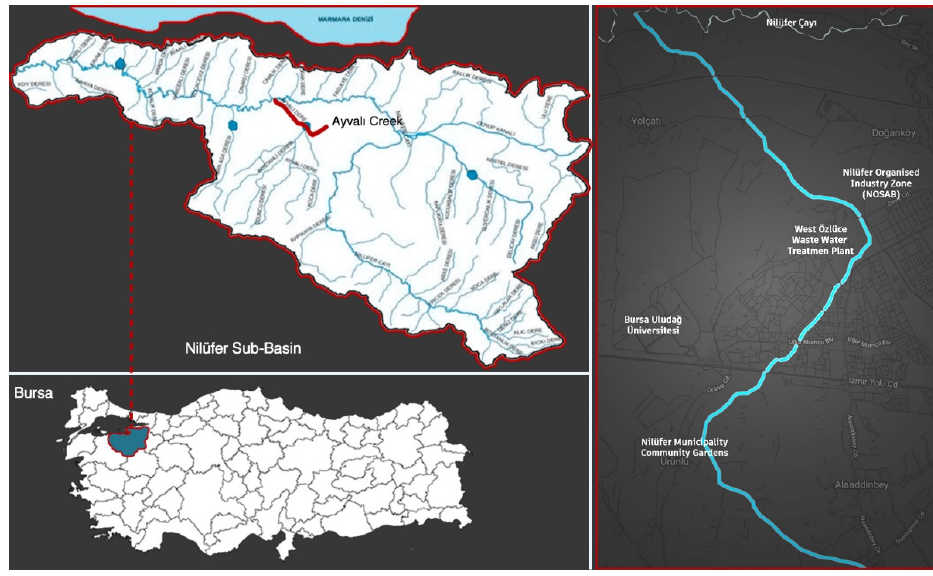
Figure 1. The study area.